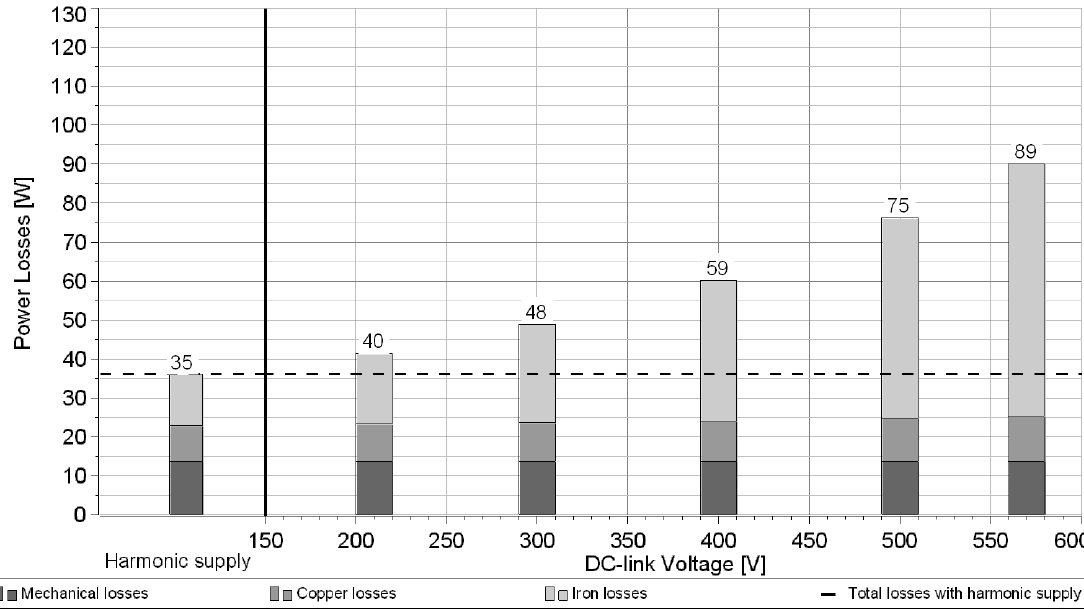
Figure 8. Motor speed 500 rpm and no-load condition: loss distribution in the case of a sinusoidal supply (left) compared to a loss distribution of the PTC-controlled induction motor (IM) (right) with the reference stator flux 1 Wb and different values of DC-link voltage.